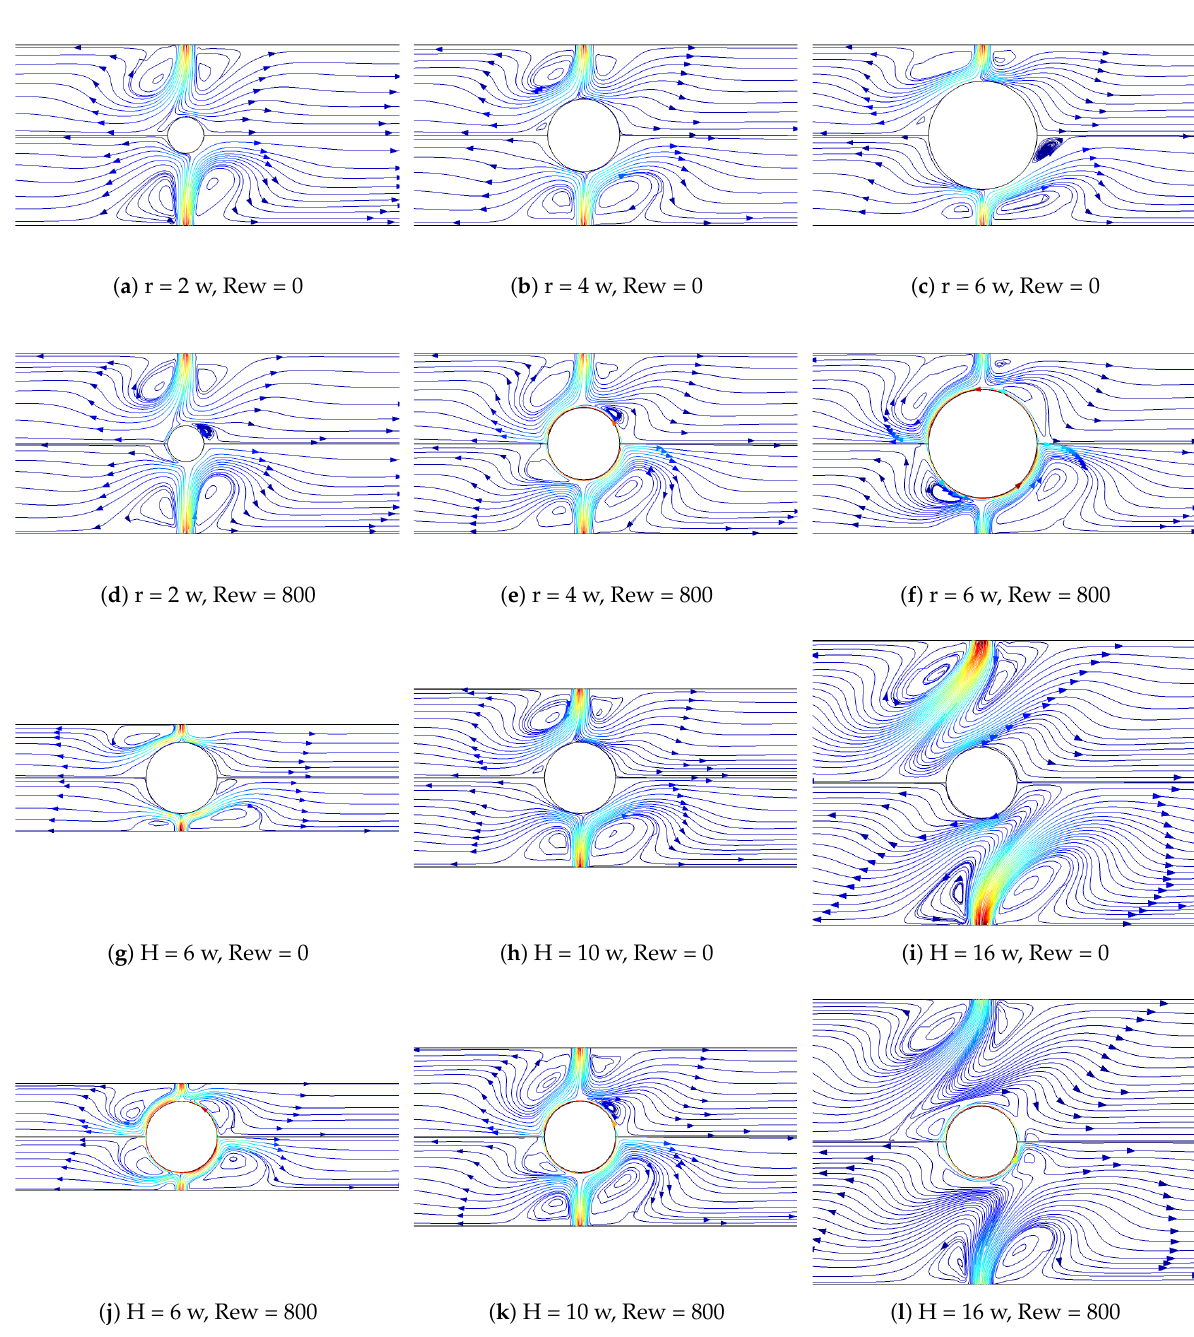
Figure 6. Effects of the hot cylinder size on the streamline distributions for the cases without ( a – c ) and with ( d – f ) rotational surface (Re1 = Re2 = 300, Ha1 = 10, Ha2 = 7.5, H = 8 w); impacts of distance from the jets to interface boundary on the streamline variations in the absence ( g – i ) and presence ( j – l ) of rotations (Re1 = Re2 = 300, Ha1 = 10, Ha2 = 7.5, r = 4